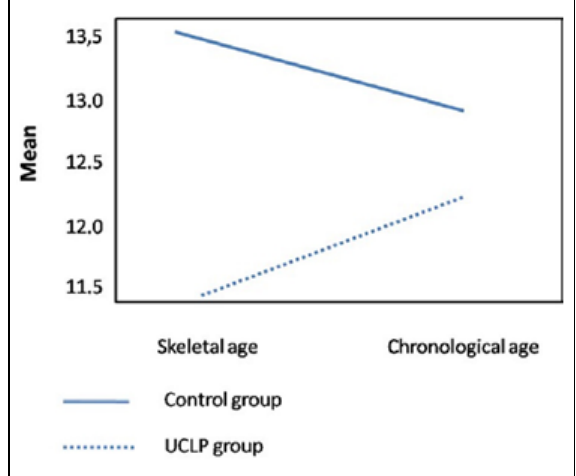
Figure 2. Mean skeletal and chronological age plots of the UCLP and control groups.